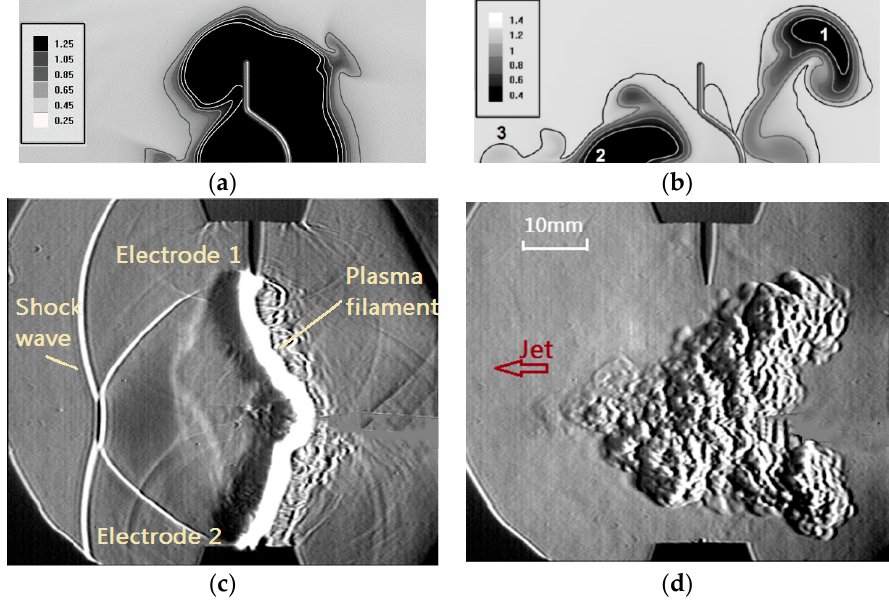
Figure 24. Density distribution at jet generation. 3D RANS simulation [139], gray scale in kg/m 3 , symmetry plane: ( a ) 50 µs; ( b ) 500 µs; (1) main jet from the external bend; (2) main jet from the central bend, and (3) fast disturbance from the central bend. Experiment (schlieren images): ( c ) 40 µs; ( d ) 540 µs.